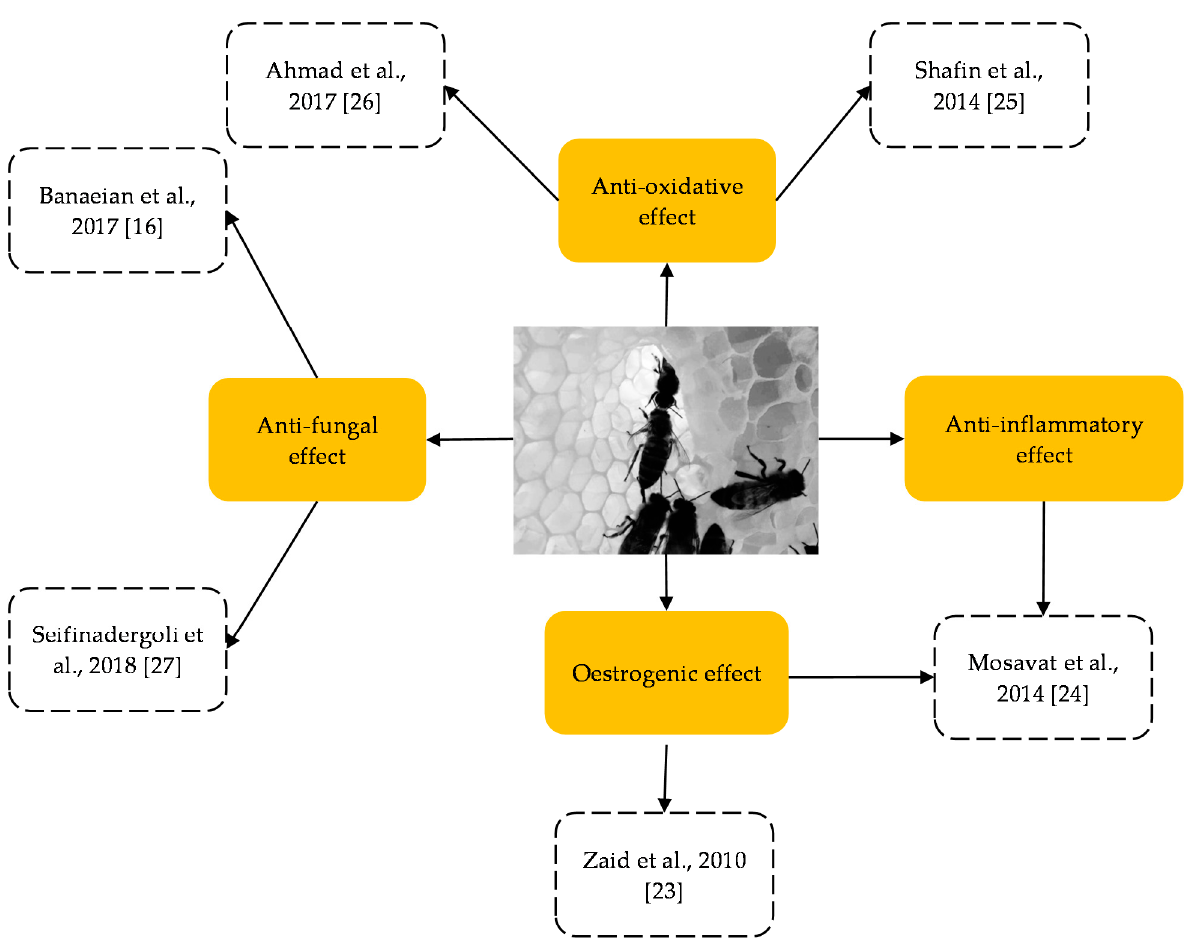
Figure 2. Categories of biological activity resulting from honey supplementation on the female reproductive system. Literature from the systematic review revealed that the six studies on the effect of honey supple mentation were clustered into four main biological effects.